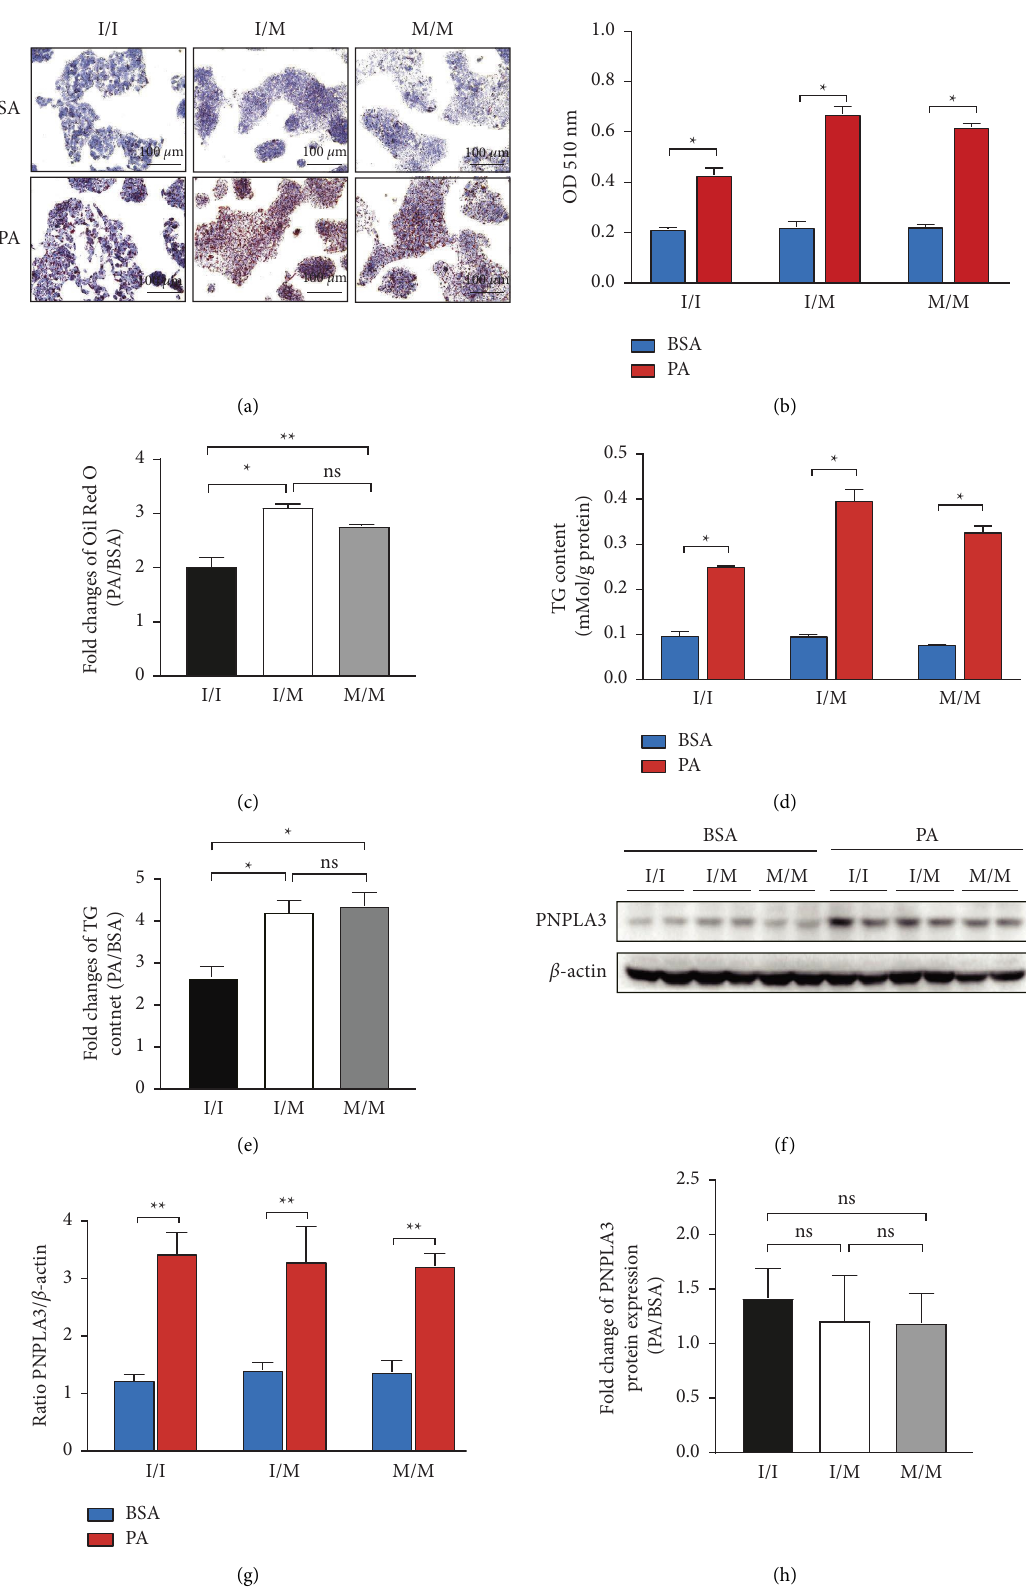
Figure 1: Lipid deposition and PNPLA3 expression. The three genotypic HepG2 cells were treated with 0.3mM PA for 24h. (a) Visualized oil red O staining using a research-grade inverted microscope at 400x magnification. The scale bar in each image represents 100 µ m. (b) Quantification of lipid measured by elution of oil red-O staining. (c) Fold change (PA/BSA) of (b). (d) Quantification of the intracellular TG content. (e) Fold change (PA/BSA) of (d). (f) The protein level of PNPLA3 detected by western blot. (g) The quantitative analysis of gray value based (f) performed using image-pro plus software. (h) Fold change (PA/BSA) of (g). Biological replicates ( N � 3) were performed per group. Quantitative data are presented as the mean ± SD ( N � 3 independent experiments). ∗ P < 0 . 05; ∗∗ P < 0 .